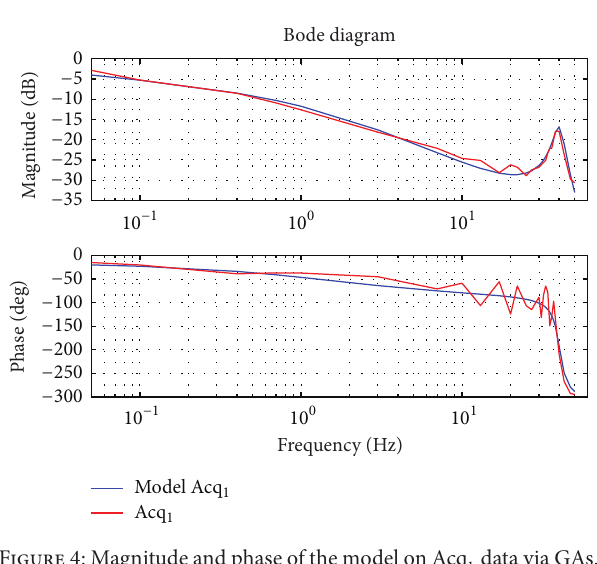
Figure 4: Magnitude and phase of the model on Acq 1 data via GAs.